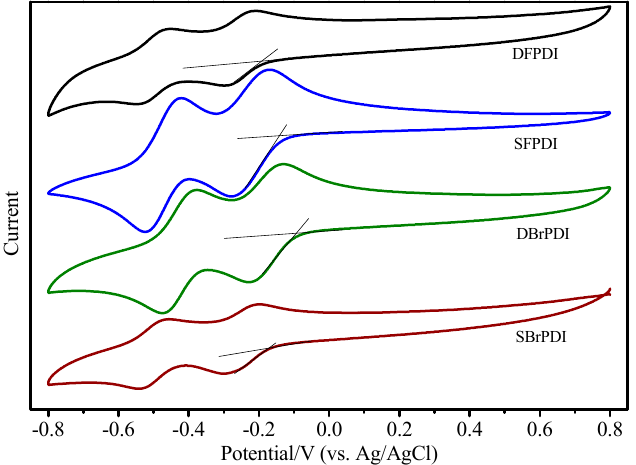
Figure 4. Cyclic voltammetry of dyes (C = 10 − 5 M) recorded in DMF containing 0.1 M n -Bu 4 NPF 6 at 0.1 Vs − 1 .